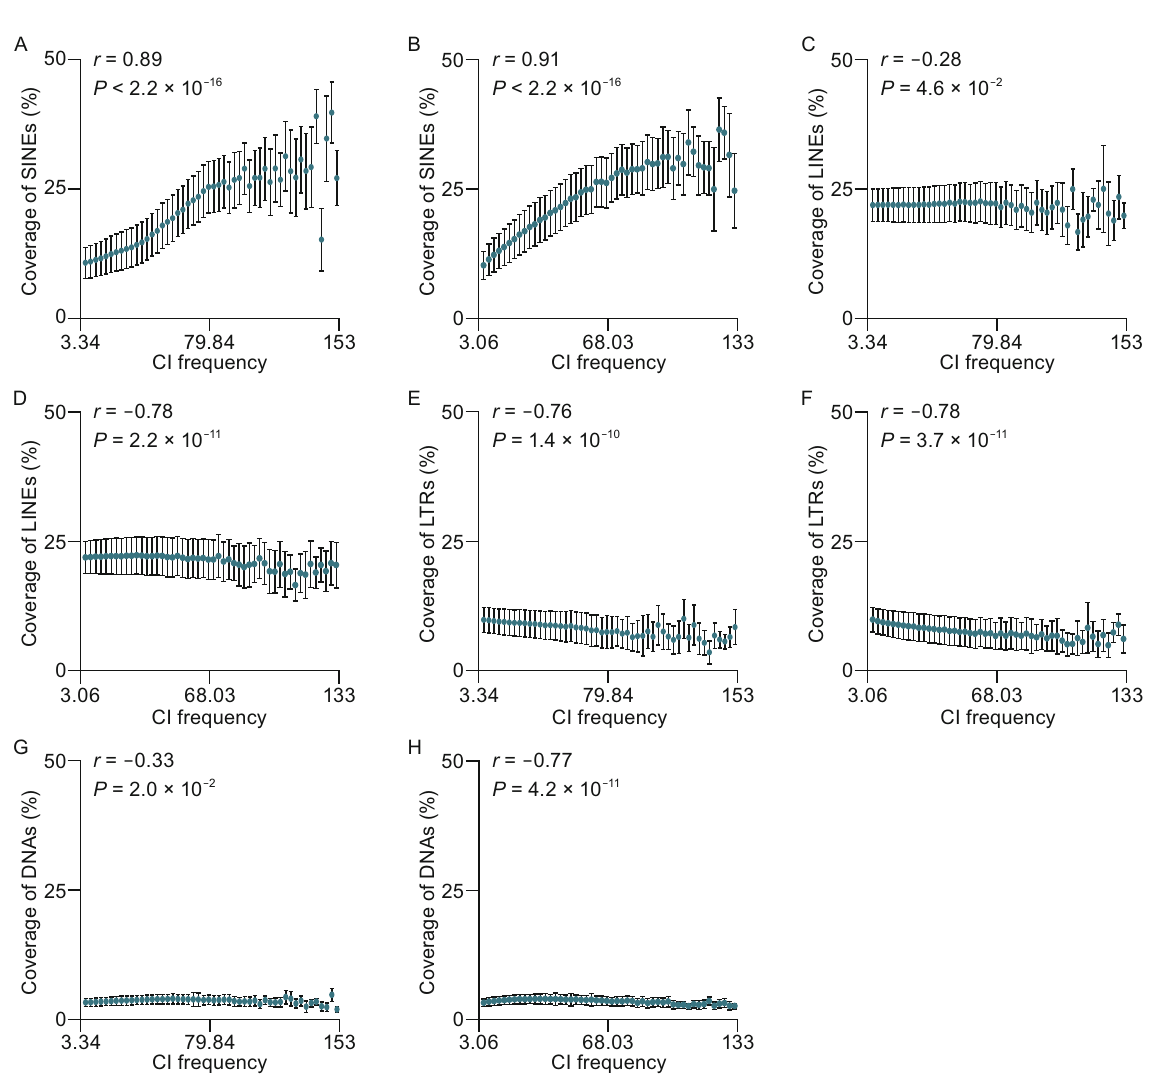
Figure 1. Mean coverage (MC) of four TE types in each 50 frequency bin. (A) The MC of SINE in 50 frequency bins in hESC. (B) The MC of SINE in 50 frequency bins in IMR90. (C) The MC of LINE in 50 frequency bins in hESC. (D) The MC of SINE in 50 frequency bins in IMR90. (E) The MC of LTR in 50 frequency bins in hESC. (F) The MC of SINE in 50 frequency bins in IMR90. (G) The MC of DNA in 50 frequency bins in hESC. (H) The MC of SINE in 50 frequency bins in